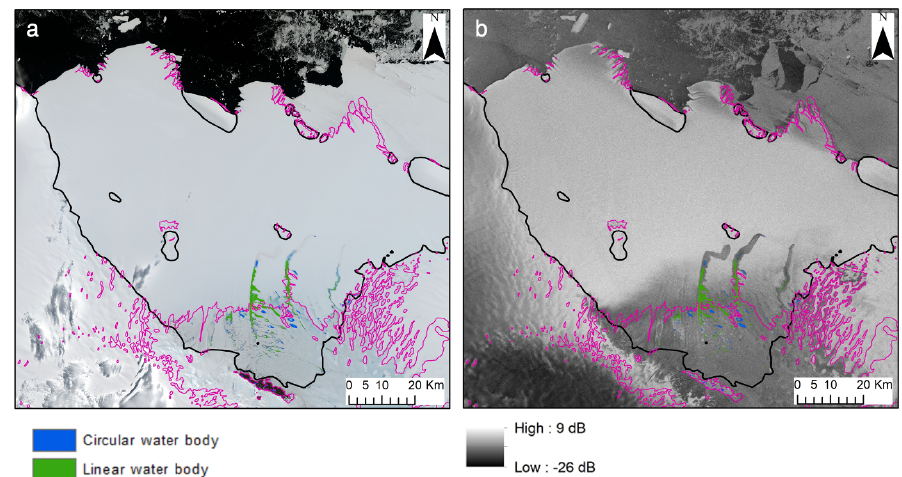
Figure 11. Comparison of optical imagery and radar imagery on 26 January 2017: panel (a) is a mosaicked Sentinel-2 image, and panel (b) is a Sentinel-1 SAR image. Both (a) and (b) are overlain with the blue ice extent (pink) and the mapped area of all linear and circular surface water bodies, based on the FASTISh analysis of (a)